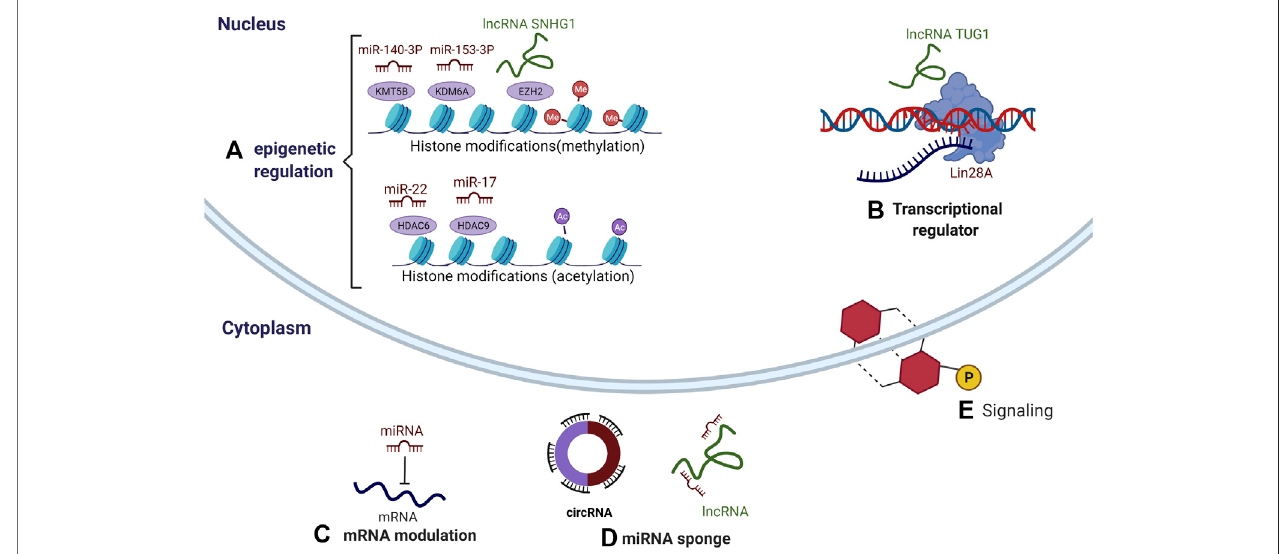
FIGURE 2 | Multiple mechanisms of ncRNAs regulating the differentiation of DMSCs. (A) Epigenetic regulation: miR-140-3p interacts with KMT5B, miR-153-3p interacts with KDM6A, and lncRNA SNHG1 interacts with EZH2, resulting in abnormal methylation. miR-22 interacts with HDAC6, and miR-17 interacts with HDAC9, resulting in abnormalacetylation. (B) gene transcription: lncRNATUG1 interacts with RBP family member-Lin28A, affecting the transcriptional activation ofdownstream genes. (C) mRNA modulation: miRNA targets the 3 ′ untranslated region (UTR) of mRNA. (D) miRNA sponges: lncRNAs and circular RNAs target miRNAs. (E) signaling: all three ncRNAs can participate in signaling